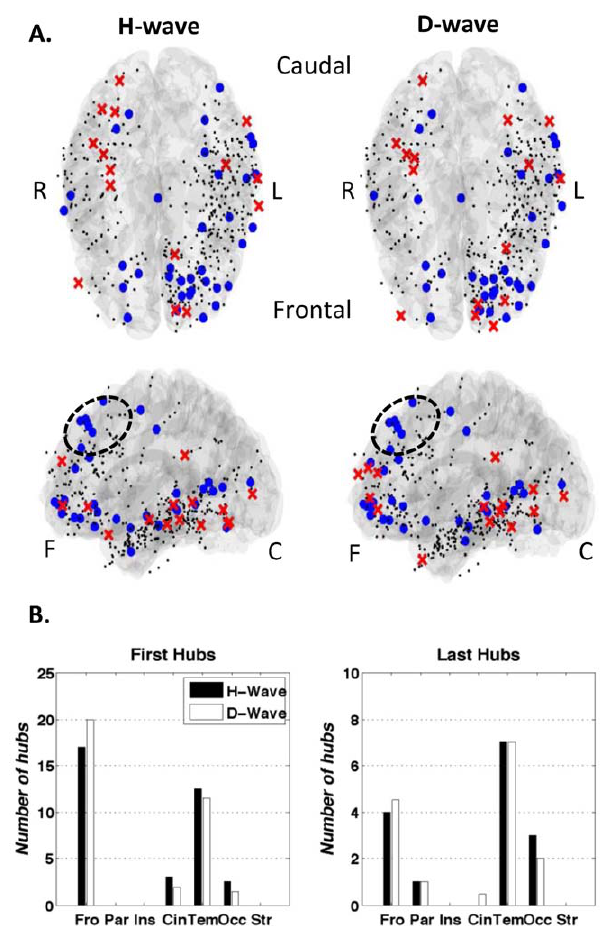
Figure 5. Results of the propagation study. A. Left: First and last hubs of the H-wave propagation of all studied subjects superimposed on the same reference brain (Top and left views). Right: First and last hubs of the D-wave propagation of all studied subjects superimposed on the same reference brain (Top and left views). The little black dots correspond to the implanted contacts not presenting a first/last hub character. These are shown to illustrate the total coverage of the sum of the individual implantations. Please note the final coverage of the sum of all the implantations is not homogeneous with 295 (71%) contacts is the left hemisphere and 122 (29%) in the right hemisphere. B. Number of first/last hubs found in each of the following regions: Frontal (Fro), Parietal (Par), Insula (Ins), Cingulate cortex (Cin), Temporal (Tem), Occipital (Occ) and Striatum (Str).